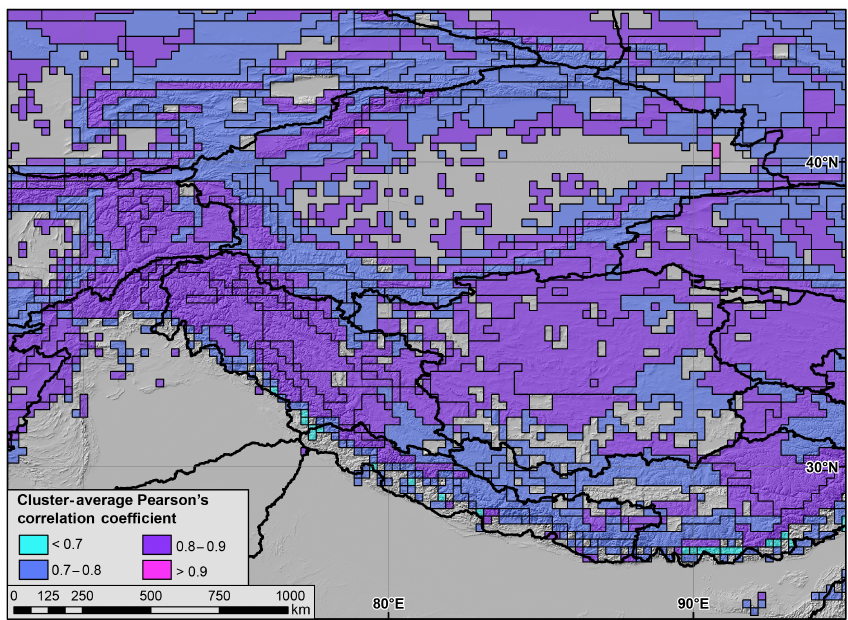
Figure 8. Hierarchical clusters (black outlines), as determined from the rank-order correlation coefficients of the 5-day resampled, merged, and linearly matched XPGR data (1987–2016). Colors indicate cluster-average internal diversity (average Pearson’s correlation coefficient between members in the same cluster). Grey areas indicate water bodies, low-SWE areas excluded from the analysis, or areas with irregular PM signals which fail to